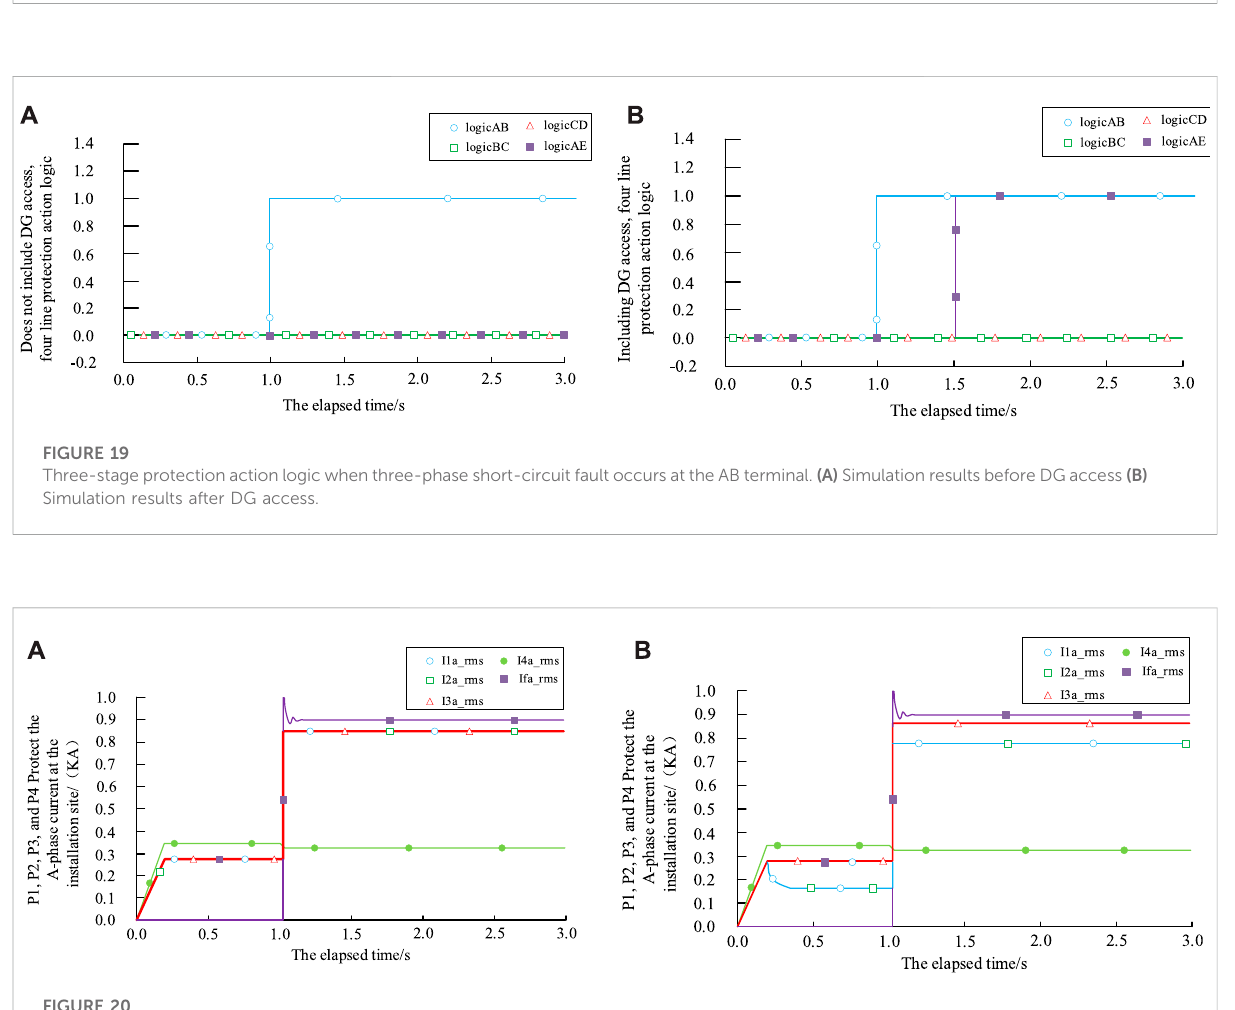
FIGURE 20 CurrentateachpositionofaCDterminalthree-phaseshort-circuitfault. (A) Simulation resultsbefore DGaccess (B) simulationresults after DG